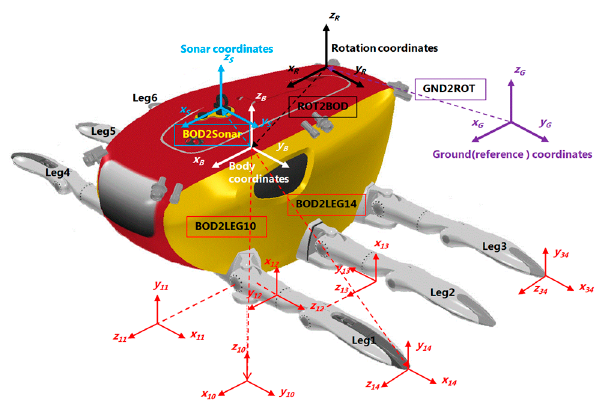
Figure 12. The coordinate system of the CR200 and installation of the scanning sonar [32].